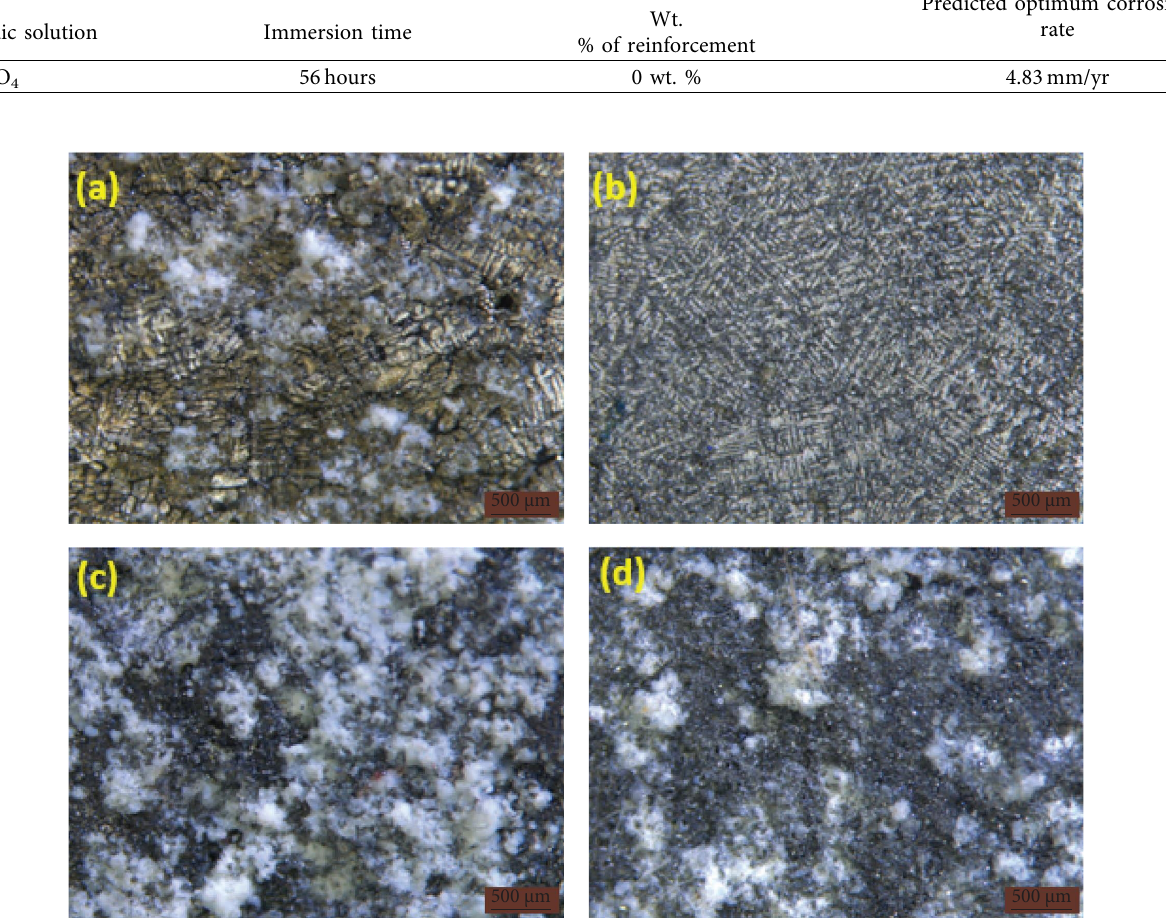
Figure 9: Surface morphology of aluminium reinforced with SiC composite at (a) exp. no 1, (b) exp. no 3, (c) exp. no 4, and (d) exp. no 7.